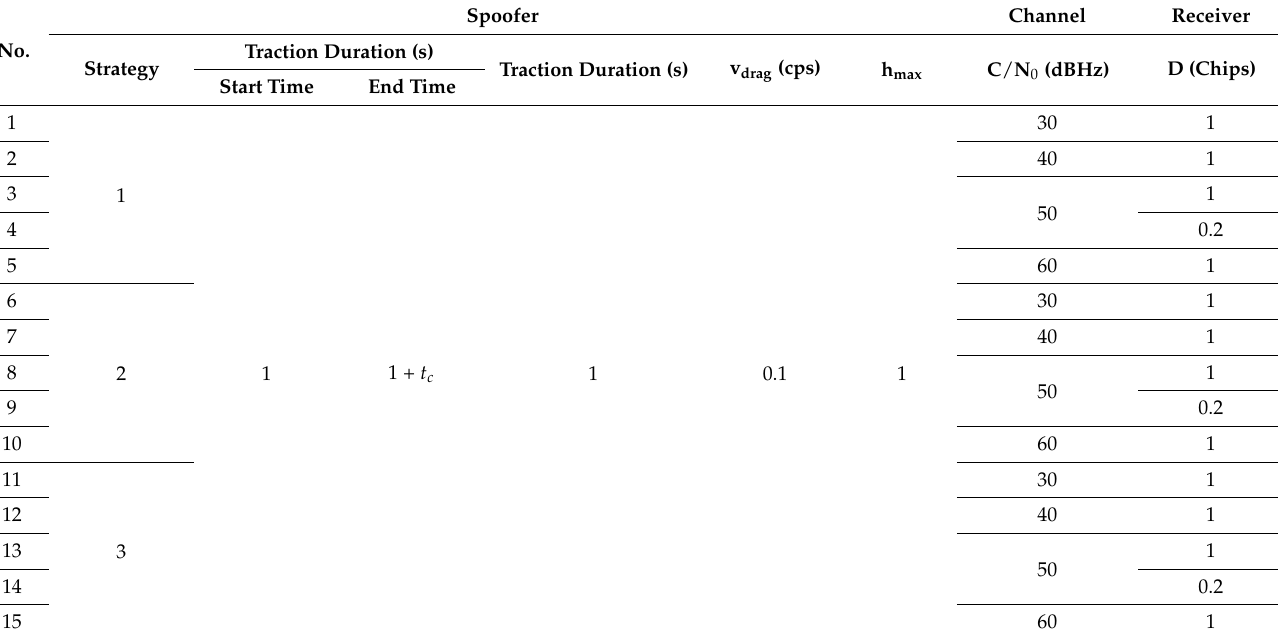
Table 2. Overview of the spoofing